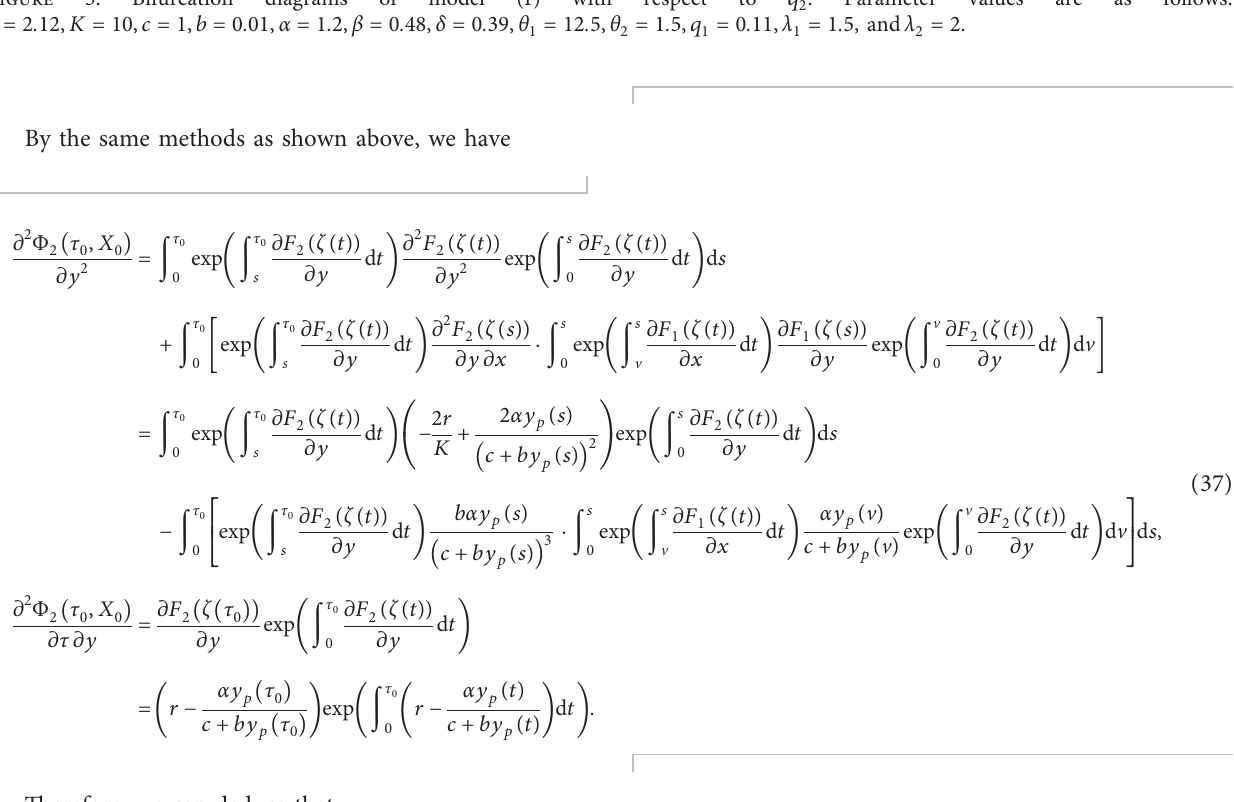
5: Bifurcation diagrams of model (1) with respect to q